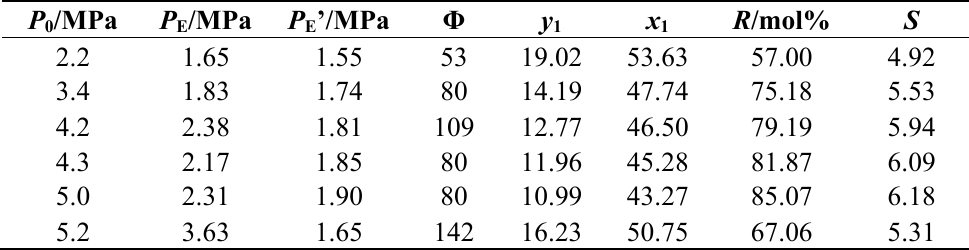
Table 1. Separation results for C 2 H 4 /CH 4 (30.08/69.92 mol%) mixture in diesel-water emulsion with different initial gas-liquid ratio Φ . Temperature and water cut were specified to 274.15 K and 30 vol%, respectively.